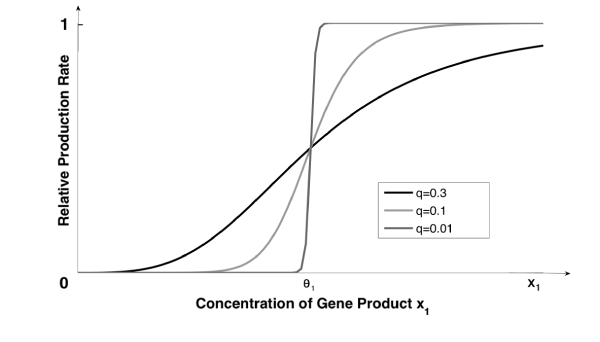
Response function shape. The sigmoid response function S(x1, θ1, q) describes the relationship between the concentration of a gene product x1 and the relative production rate of the regulated gene. The parameter q determines its steepness around the threshold θ1.